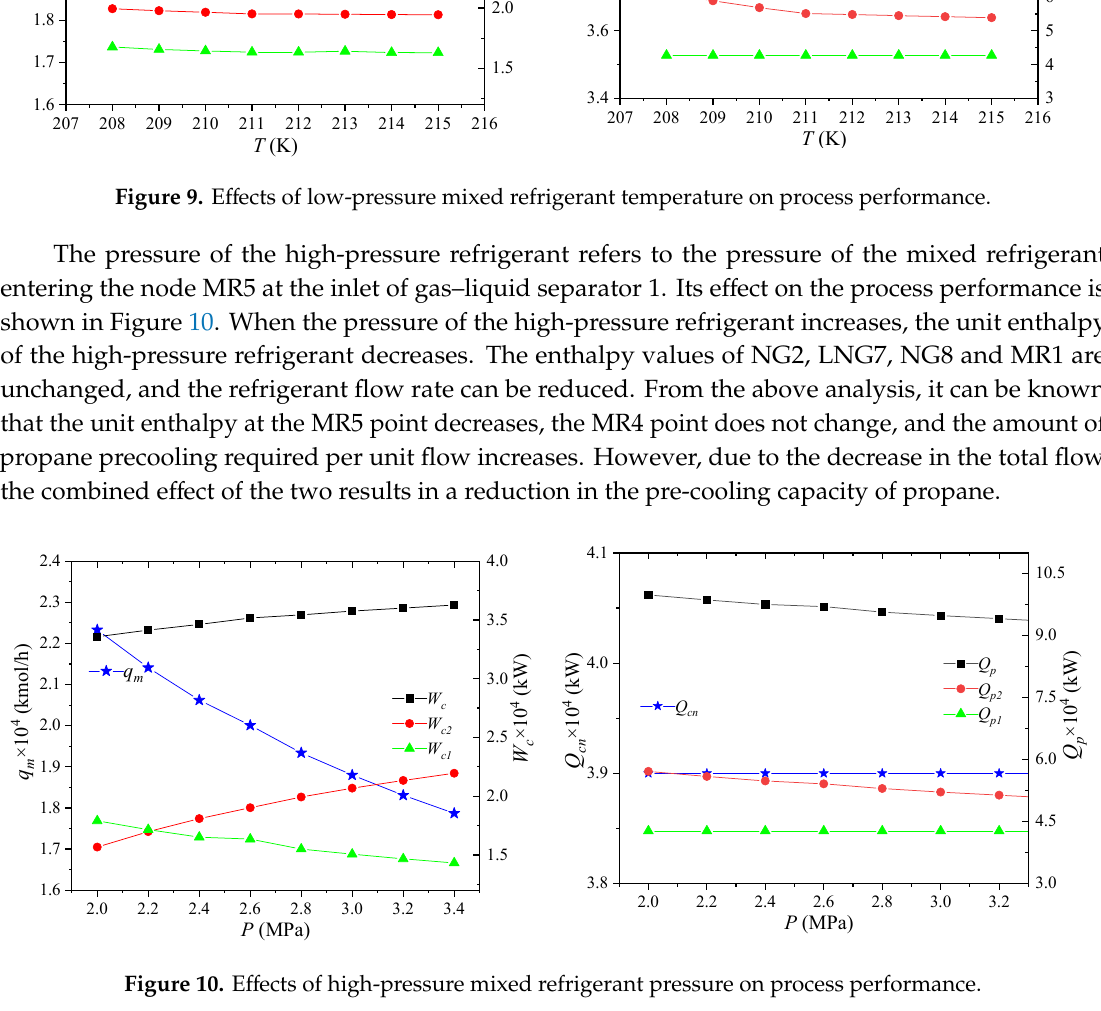
Figure 10. Effects of high-pressure mixed refrigerant pressure on process performance.